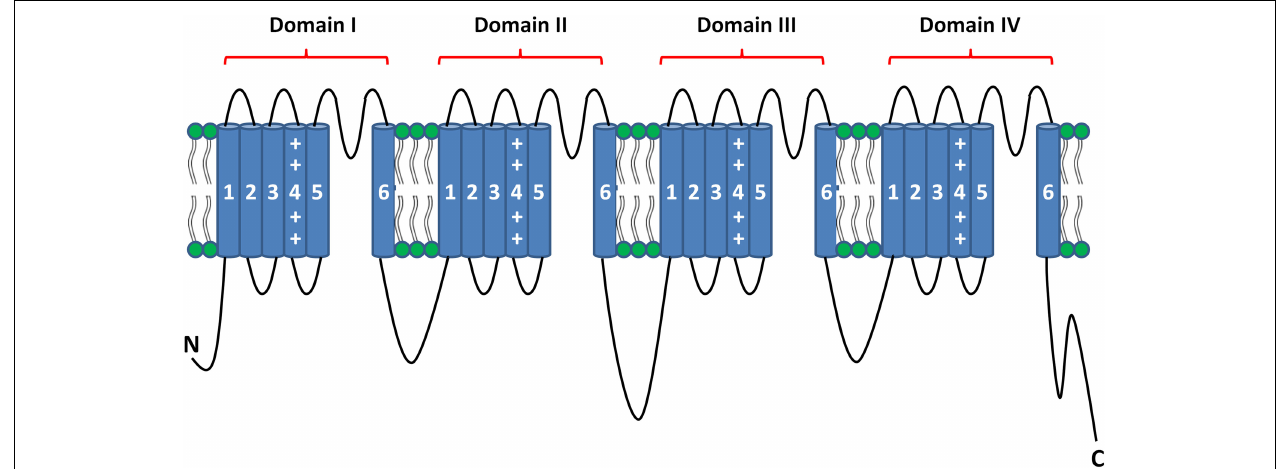
FIGURE 1 | Topology of the pore-forming α -subunit of voltage gated sodium